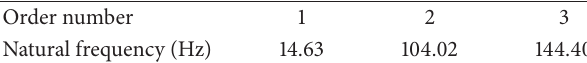
Figure 6: A schematic view of the experimental setup.